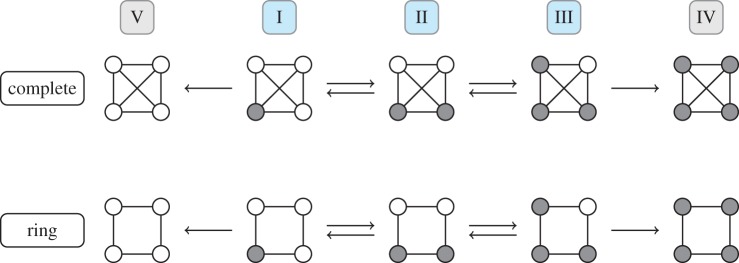
The five states of a Markov chain on a complete graph and a ring of size four. Grey nodes indicate mutants, whereas white nodes represent wild-type individuals. The arrows show possible transitions between states of the chain in one time step. The process can also stay in the same state whenever a mutant or wild-type individual replaces one of its own kind. The process starts at state I and moves around on the state space until it reaches one of the absorbing states IV or V. Note that for these two networks, the same transitions are possible, but the transition probabilities are different. (Online version in colour.)